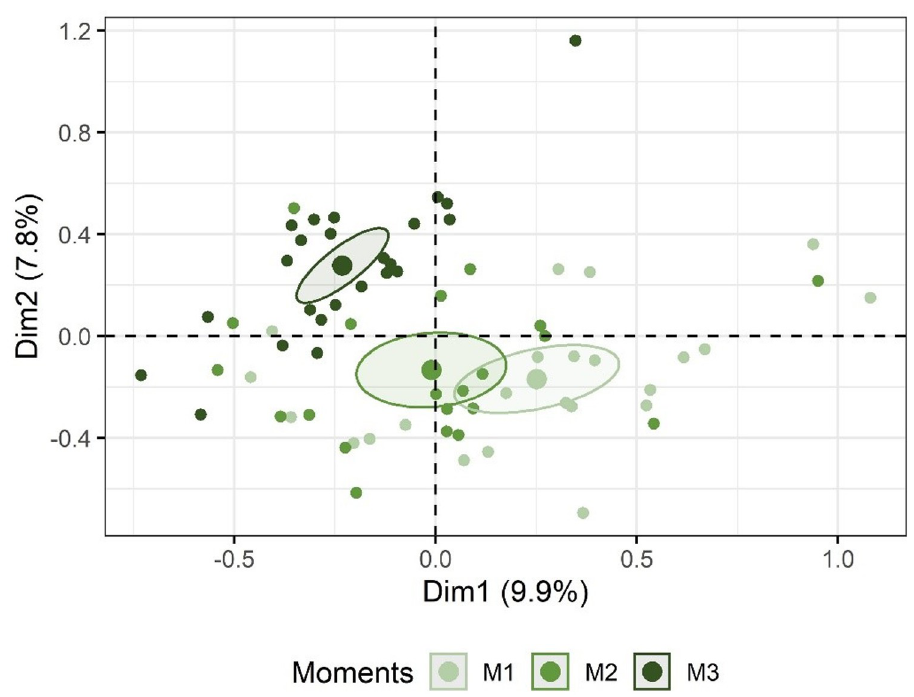
Fig 8. Projection of individuals (Child+M) obtained in a multiple correspondence analysis (MCA) performed on categorical variables. Confident ellipses for Moments were set at 95% confidence level.